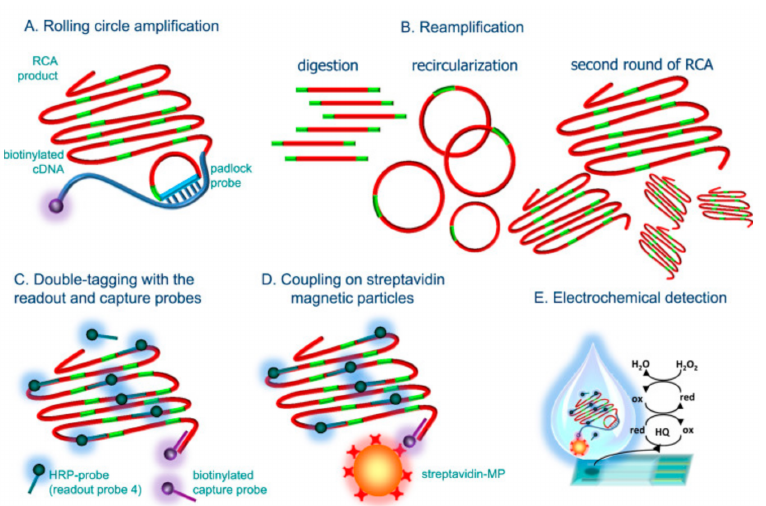
Figure 6. Schematic representation of electrochemical detection following hybridization of probe with target sequence. ( A ) RCA of circularized probe occurs followed by ( B ) its digestion and subsequent recircularization allowing for a second round of RCA to occur. ( C ) DNA products were double tagged using HRP probe and biotinylated capture probe, ( D ) which allowed for coupling of biotinylated DNA onto streptavidin magnetic particles. ( E ) Finally, enzymatic reaction of HRP using H2O2 as a substrate was detected. [107] Reused with permission from